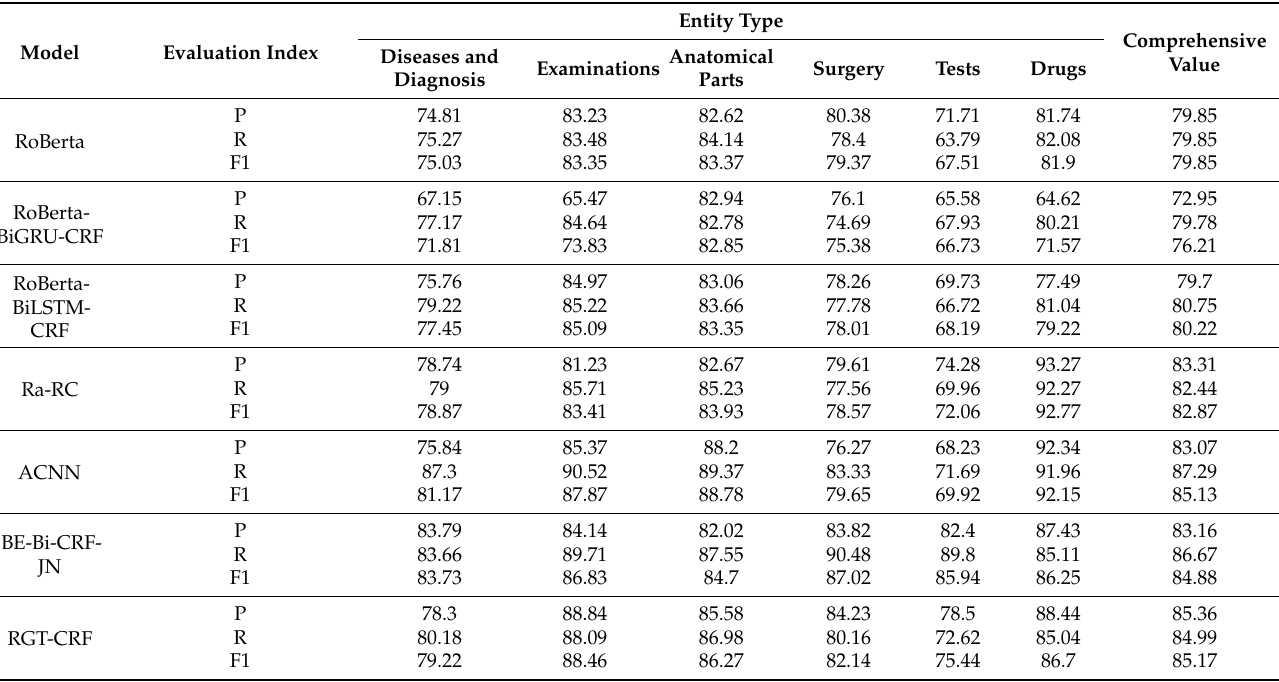
Table 4. Results of different models on CCKS2019.